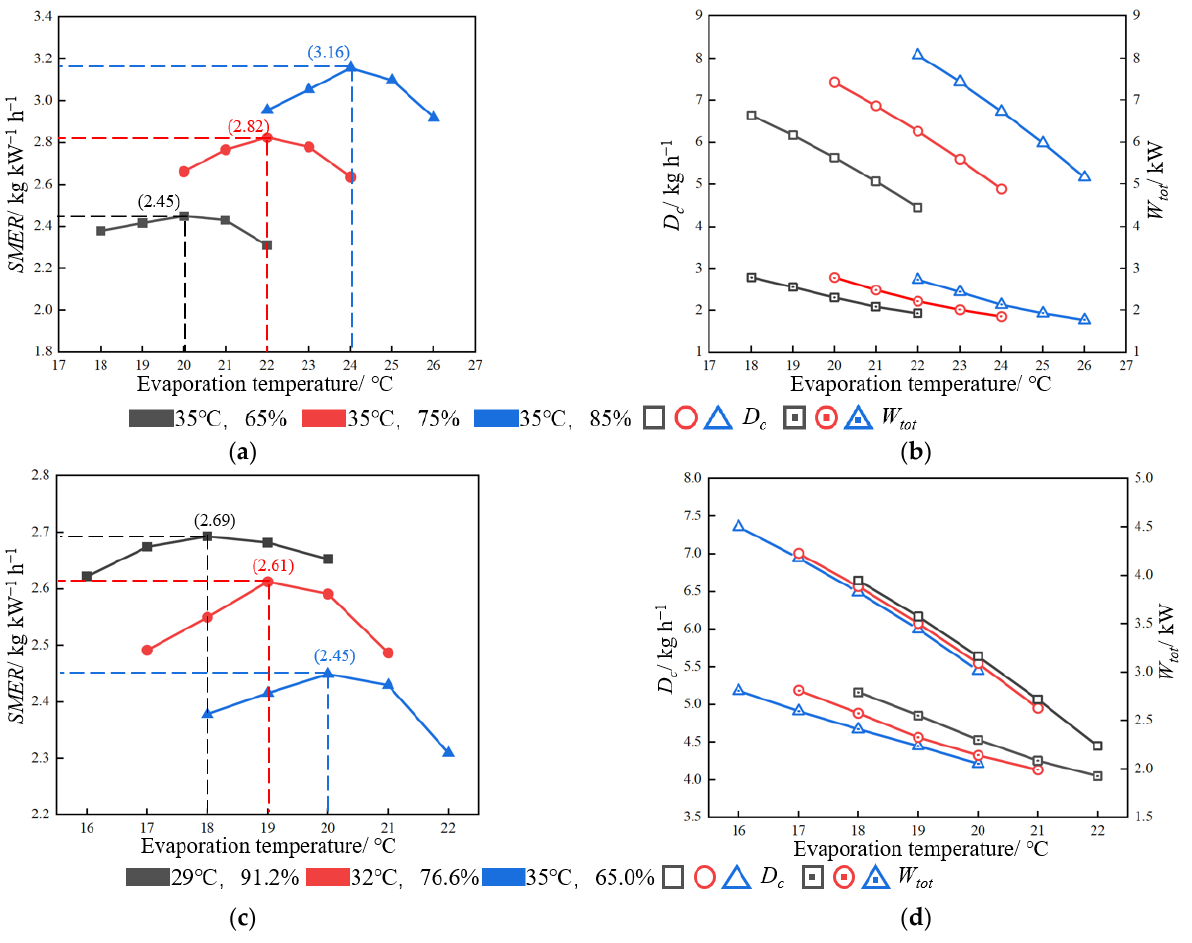
Figure 4. The effects of evaporation temperature on performance. ( a ) Specific moisture extraction rate ( SMER ). ( b ) D c and W tot . ( c ) SMER . ( d ) D c and W tot